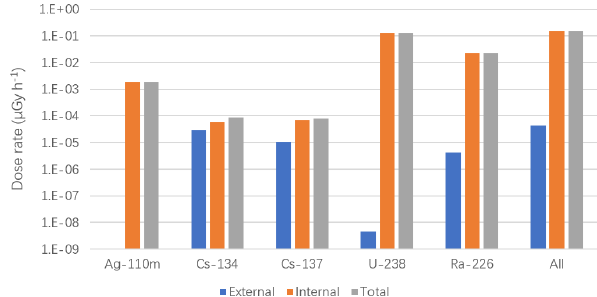
Figure 3. Dose rates (µGyh − 1 ) from measured radionuclides in squid